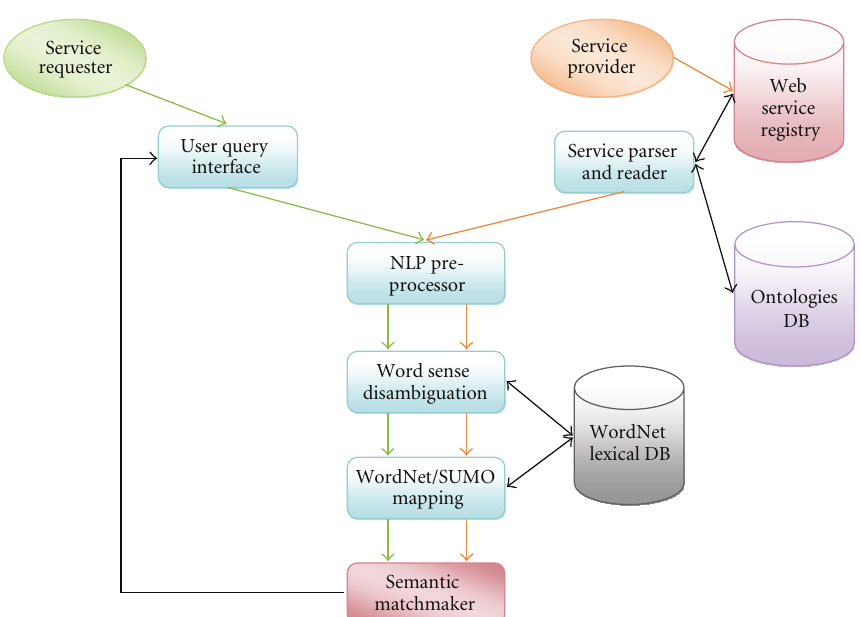
Figure 1: Automatic Web service discovery framework architecture.